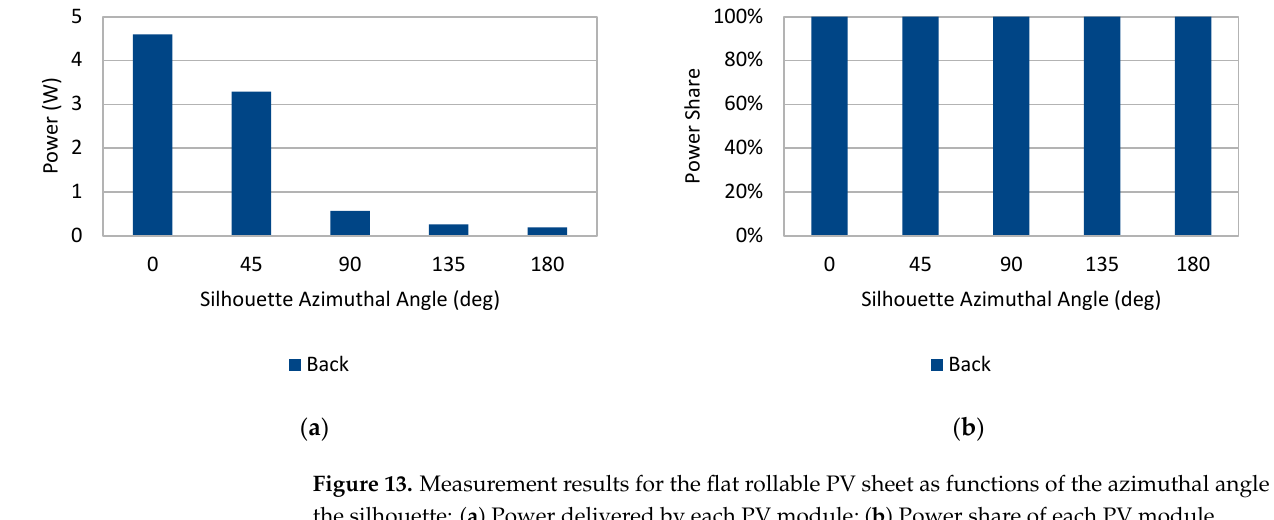
Figure 13. Measurement results for the flat rollable PV sheet as functions of the azimuthal angle of the silhouette: ( a ) Power delivered by each PV module; ( b ) Power share of each PV module.